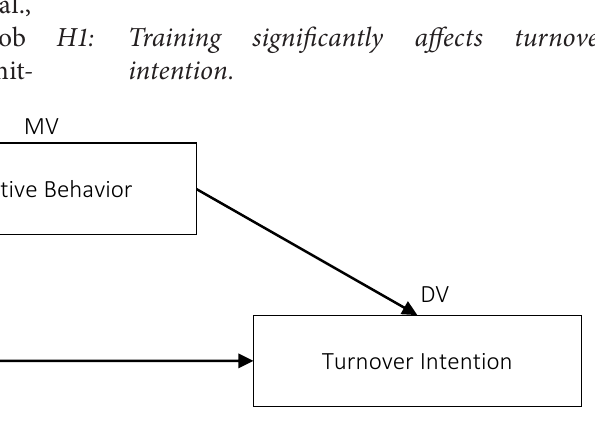
Figure 1. Research